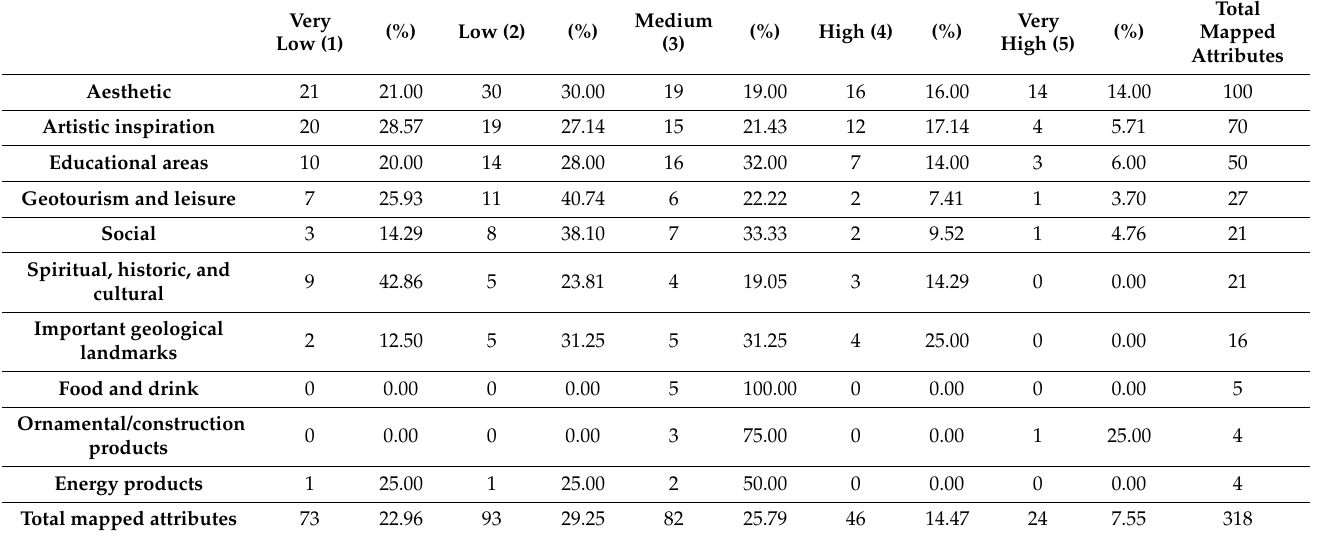
Table 4. Frequencies and percentages of mapped geosystem services (GS) marker categories associ- ated with geodiversity index score